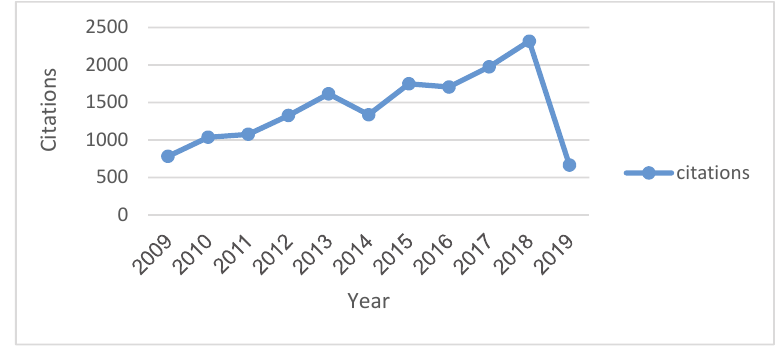
Fig. 3. Citations overview in the last ten years